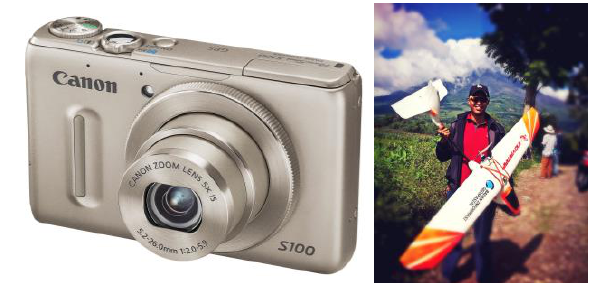
Figure 3. UAV fixed wing and camera used (left: Skywalker 1680, right: Canon S-100)